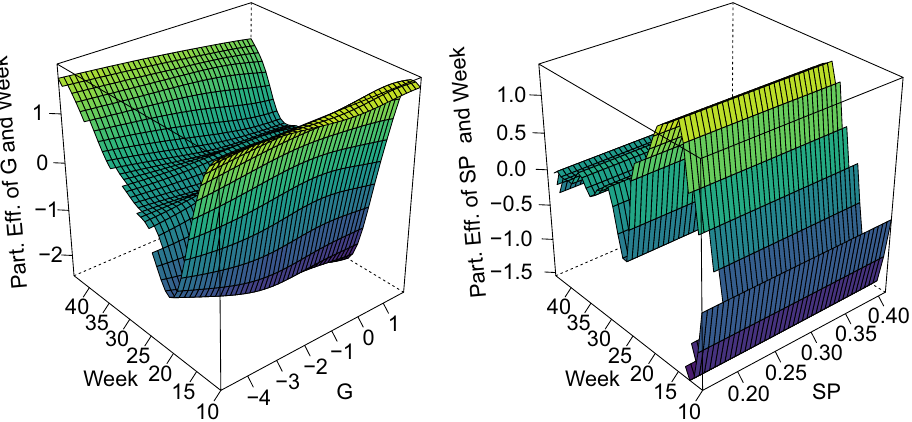
Figure 4. Estimated bivariate partial effects of the week and Gini coefficient (G) on the left as well as of the week and Percentage Staying Put (SP) on the right. For weeks 10 to 30, low standardized Gini coefficients come with low infection rates. Thus, more focused meeting patterns are associated with lower infection rates in that time frame. The effect of people staying put is negative at the beginning of the observational period and in the end. Hence, a higher percentage of people staying put is related to lower infection